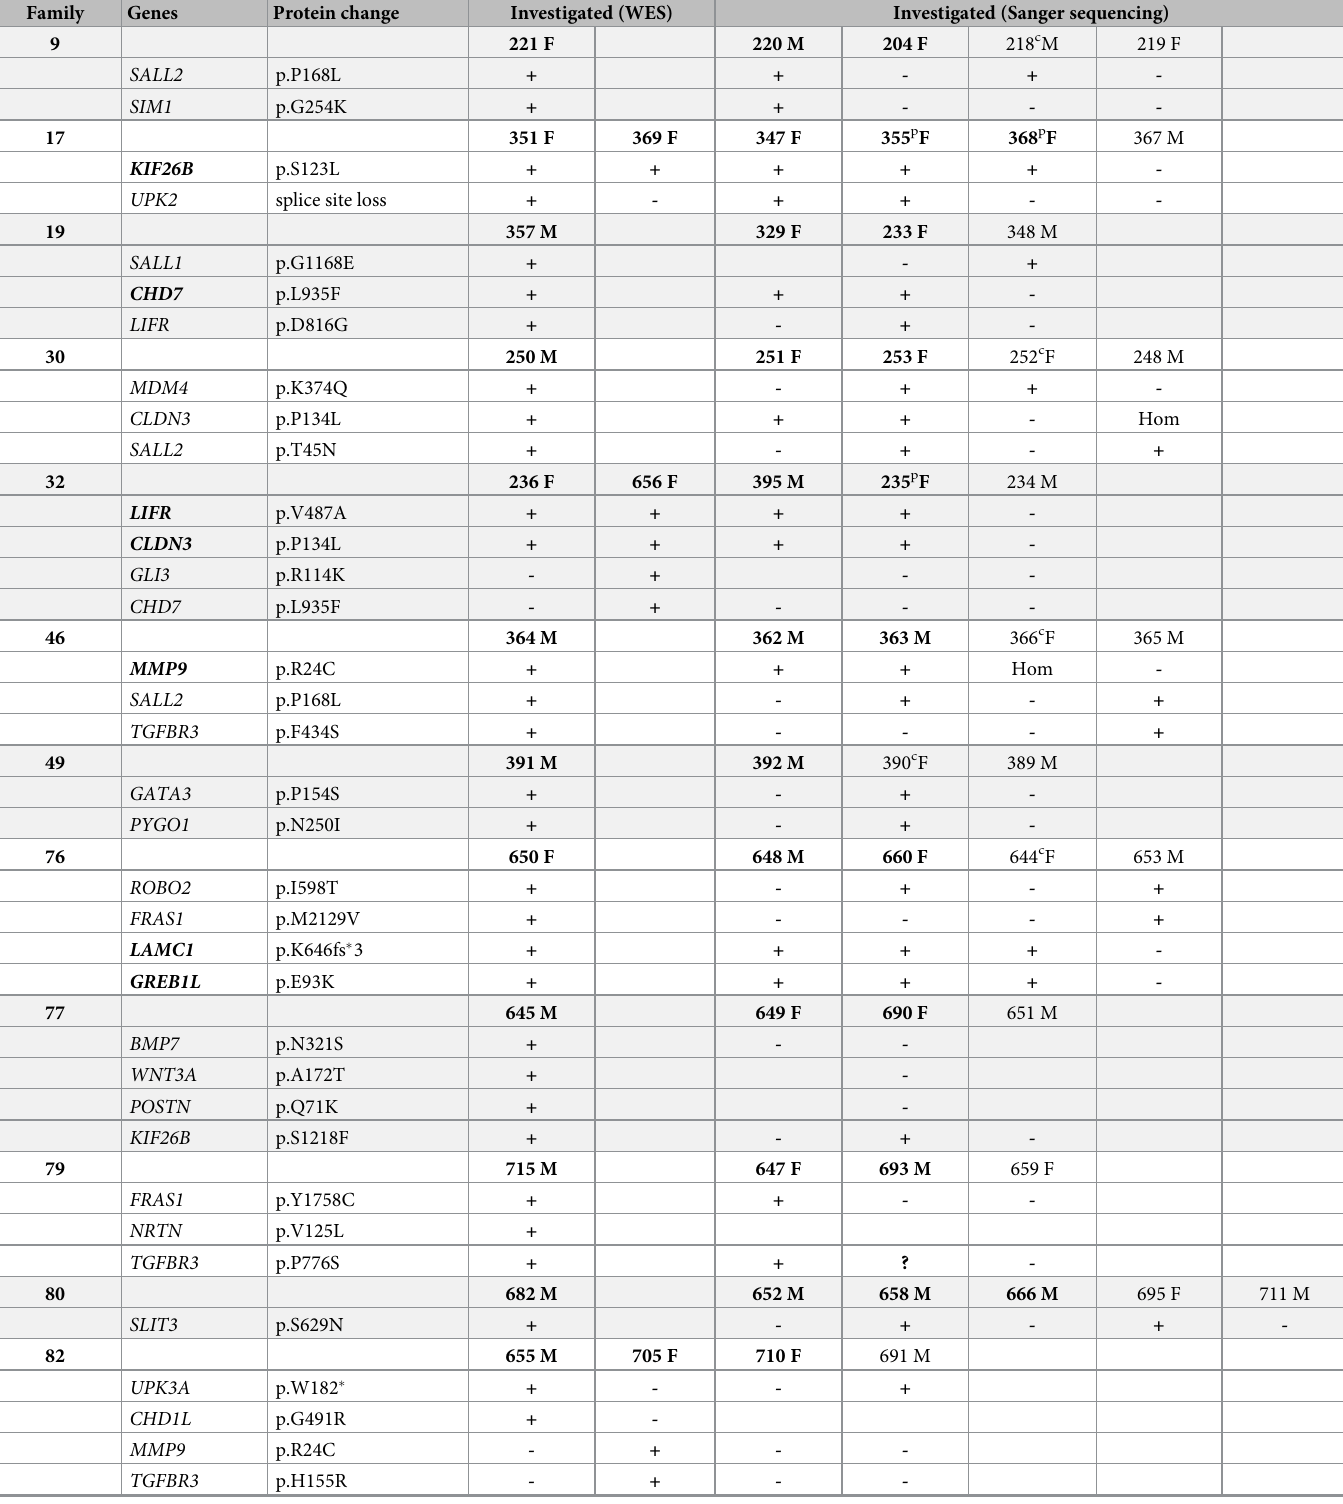
Table 2. Results of Sanger sequencing used for segregation analysis in 13 families with hereditary VUR.